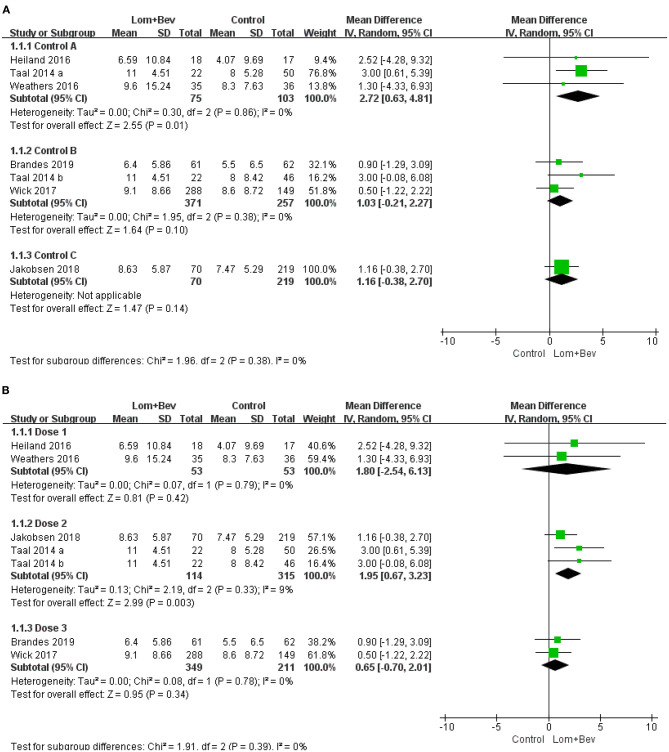
Subgroup analysis of OS in glioblastoma according to (A) different control groups, (B) different dose groups. Control group A, bevacizumab monotherapy; Control group B, lomustine monotherapy or lomustine plus placebo; Control group C, bevacizumab plus irinotecan; Dose1, Bev(5 mg/kg every 3 weeks) + Lom(90 mg/m2 every 6 weeks); Dose2, Bev (10 mg/kg every 2 weeks) + Lom (90 mg/m2 every 6 weeks); Dose3, Bev(10 mg/kg every 2 weeks) + Lom (90–200mg/m2 every 6 weeks).